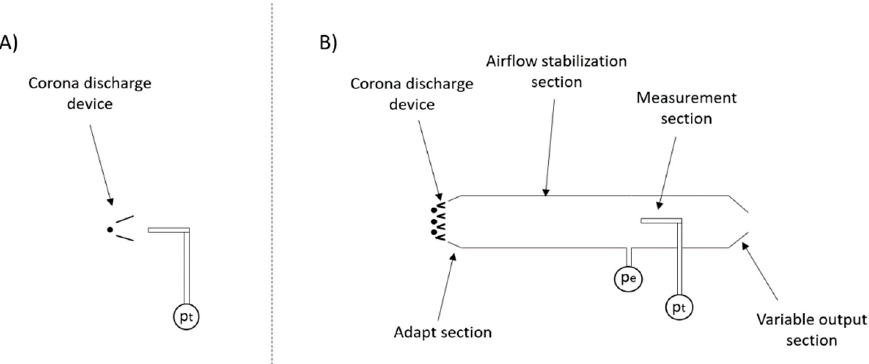
Figure 4. Experimental set-up for the electrical and aerodynamic characterization of an electrode